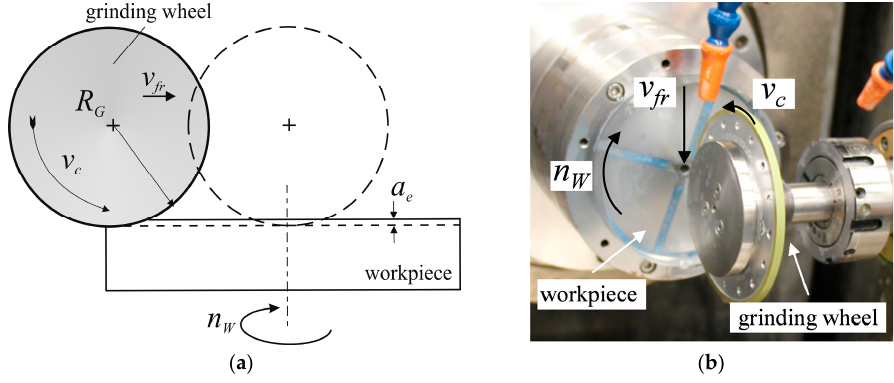
Figure 1. ( a ) Grinding kinematics—cross grinding with rotating workpiece; ( b ) Machine setup. Table 1. Process parameters.